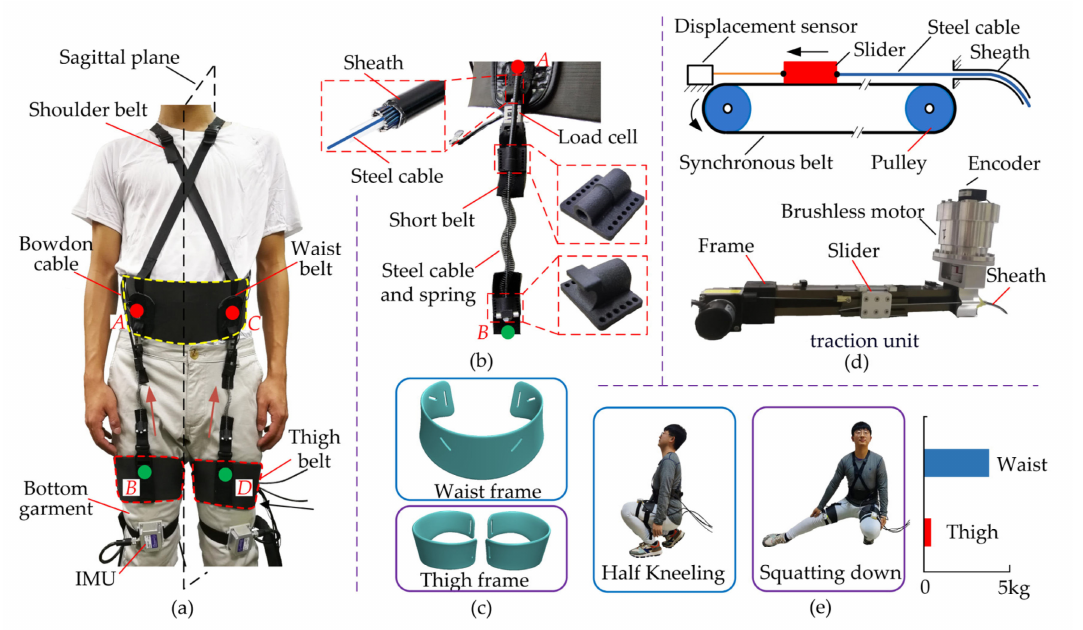
Figure 2. Development of the H-Suit system. ( a ) The H-Suit consists of a soft exosuit, external traction units and Bowden cables where A , B , C and D are anchor points. ( b ) The sheath and steel cable of the Bowden cable are respectively fixed in the upper and lower components. ( c ) The open frames of the waist and thigh are designed and fitted with the physiological structures of the human